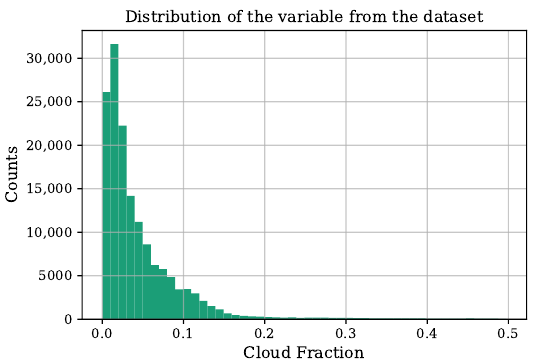
Figure 1. Distribution of the variable cloud fraction for the dataset used in this